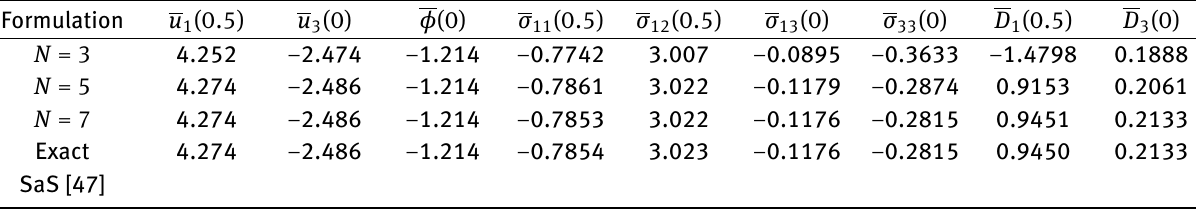
Table 3: Results for a FGM piezoelectric square plate with a / h = 10 and α = −1 using a uniform 64 × 64 mesh.